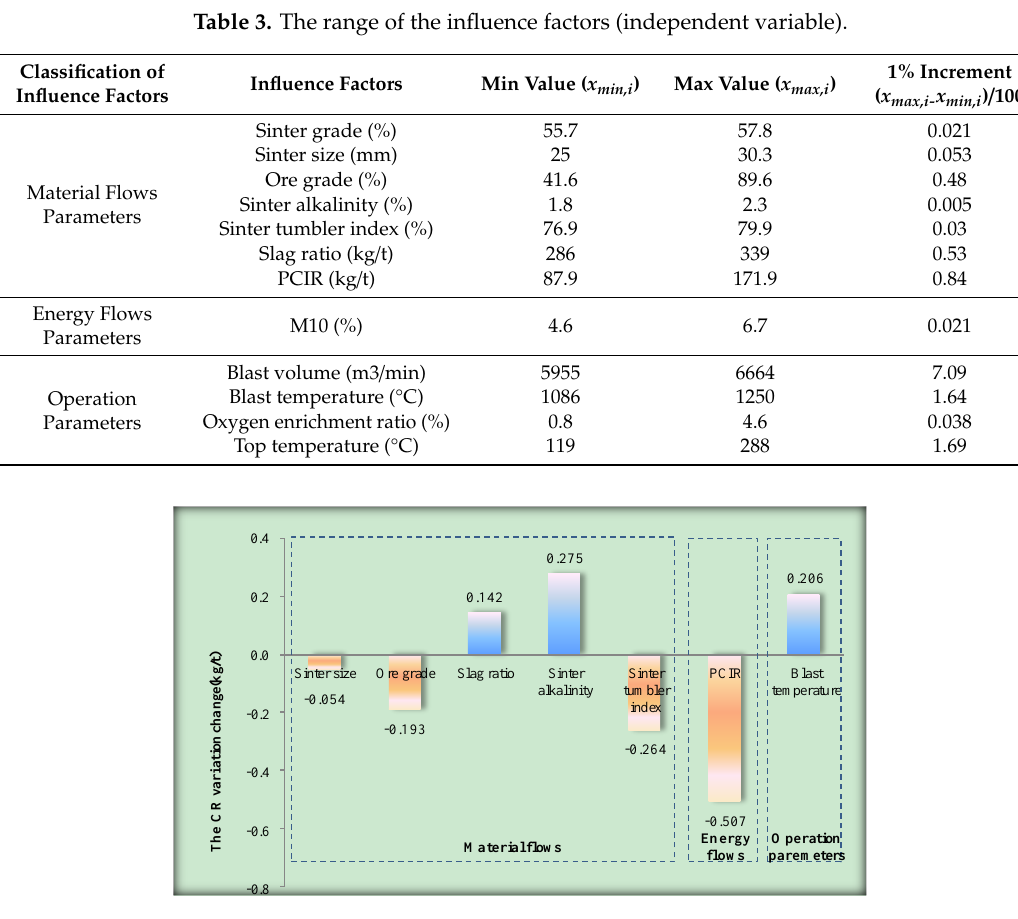
Figure 7. The influence intensity of significant factors on CR.